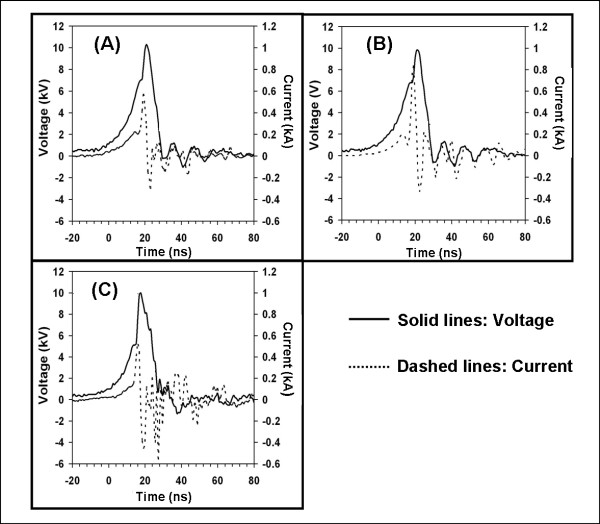
Typical voltage and current pulse waveforms delivered to the PC3 cell monolayer in DMEM growth medium with three types of electrode configurations. (A) single-needle, (B) five-needle array, and (C) flat-cut cable.